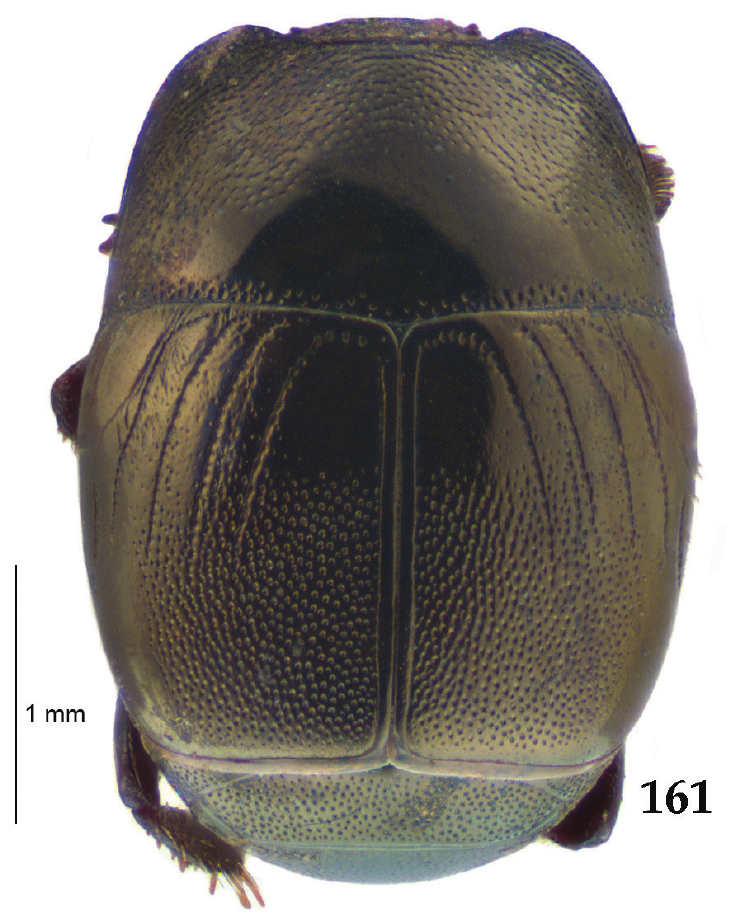
Figure 161. Hypocaccus ( Hypocaccus ) sinae (Marseul, 1862) habitus, dorsal view. Saprinus vernulus Blackburn, 1903: Lectotype, present designantion: ♀ , mounted on a card with “ ♀ ” (printed), followed by: “7249” (mount card with a red number, printed); followed by: “N.S. Wales” (printed); followed by: “K. 270214” (printed); followed by: “ Hypocaccus / vernulus / Cotype” (written); followed by: “ Hypocaccus / vernulus Bl.” (written); followed by: “SYNTYPE” (yellow label, written); followed by: “Saprinus vernulus / Blackburn, 1903 / LECTOTYPE des. / T. Lackner 2016” (red label, written) (AMS). This specimen has been described based on unknown number of specimens and the lectotype designation fixes the identity of the species. Additional material examined. AUSTRALIA. New South Wales: 2 specs., re- mounted on a single pin, with the same labels as the lectotype, (and certainly from the same collection – D. Smith pers. comm.) except the original mount with red number “7248” instead of “7249” and with “K270229” instead of “K. 270214” of the